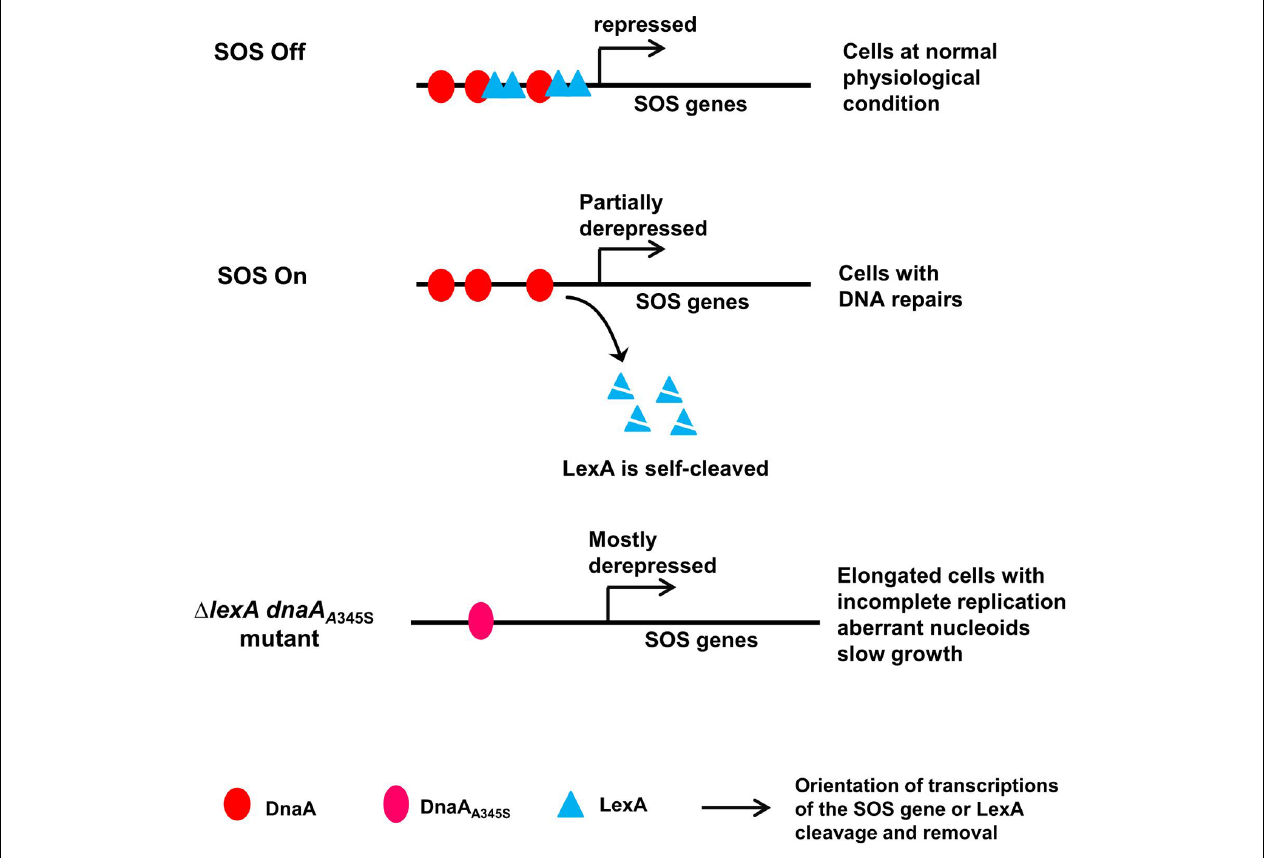
FIGURE 8 | A model for control of the SOS regulon by DnaA and LexA. In the proposed model, both DnaA and LexA repress expression of the SOS genes when SOS is off. When SOS is on, LexA is self-cleaved, but DnaA-repression still works, leading to partial expression of the SOS genes and consequent cells with normal nucleoids and growth. In the simultaneous absence of LexA- and DnaA-repression, the SOS genes are mostly derepressed, forming elongated cells with incomplete replication, aberrant nucleoids and slow growth. The red ovals represent the DnaA protein, the cyan triangles represent the LexA protein, the pink oval represents the DnaA A345S mutant protein, arrows indicate orientation of transcriptions of the SOS gene or LexA cleavage and removal as